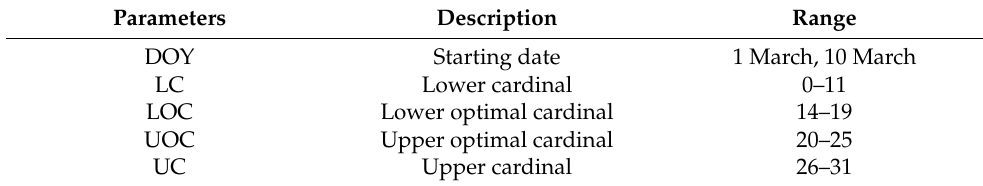
Table 4. Parameter ranges tested for model